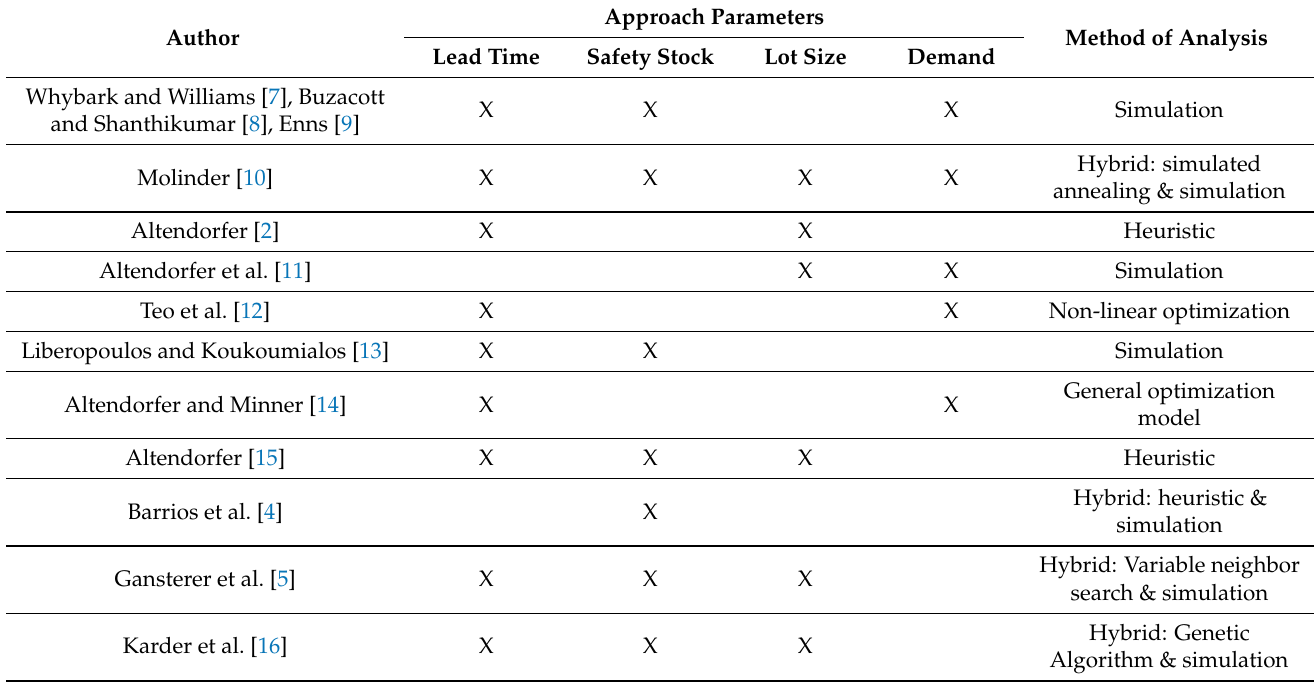
Table 1. Related work